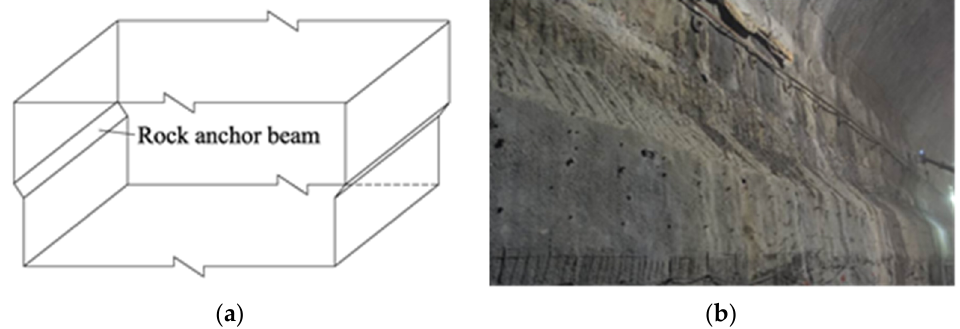
Figure 12. Rock anchor beam zone of underground powerhouse. ( a ) The excavation diagram of the rock anchor beam zone. ( b ) The engineering scene of the rock anchor beam zone.